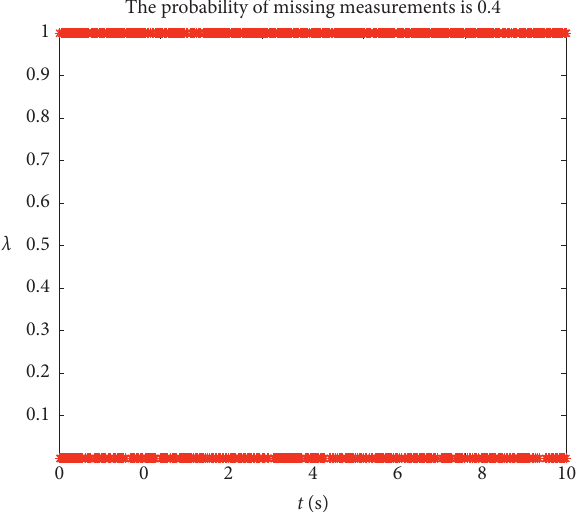
Figure 8: The missing measurements in feedback channel.